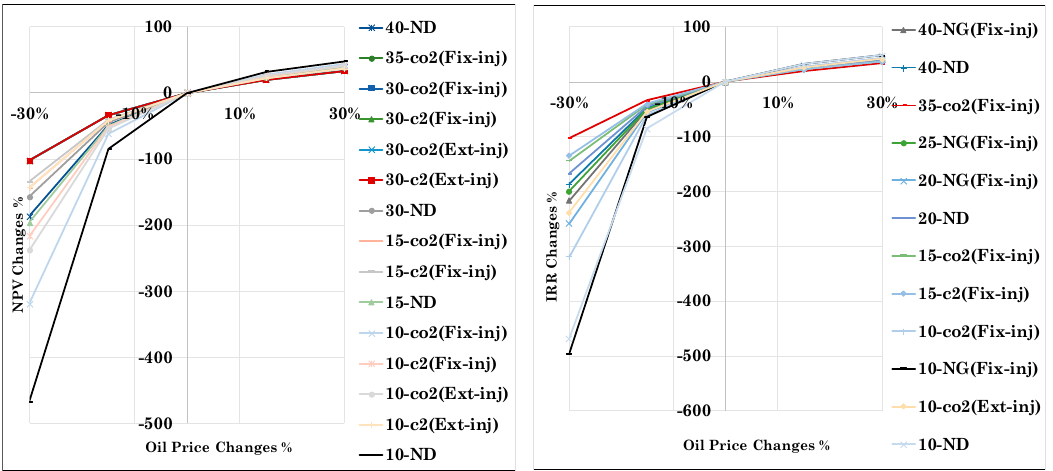
Figure 34. Changes in NPV and IRR coming from variation in Oil Price